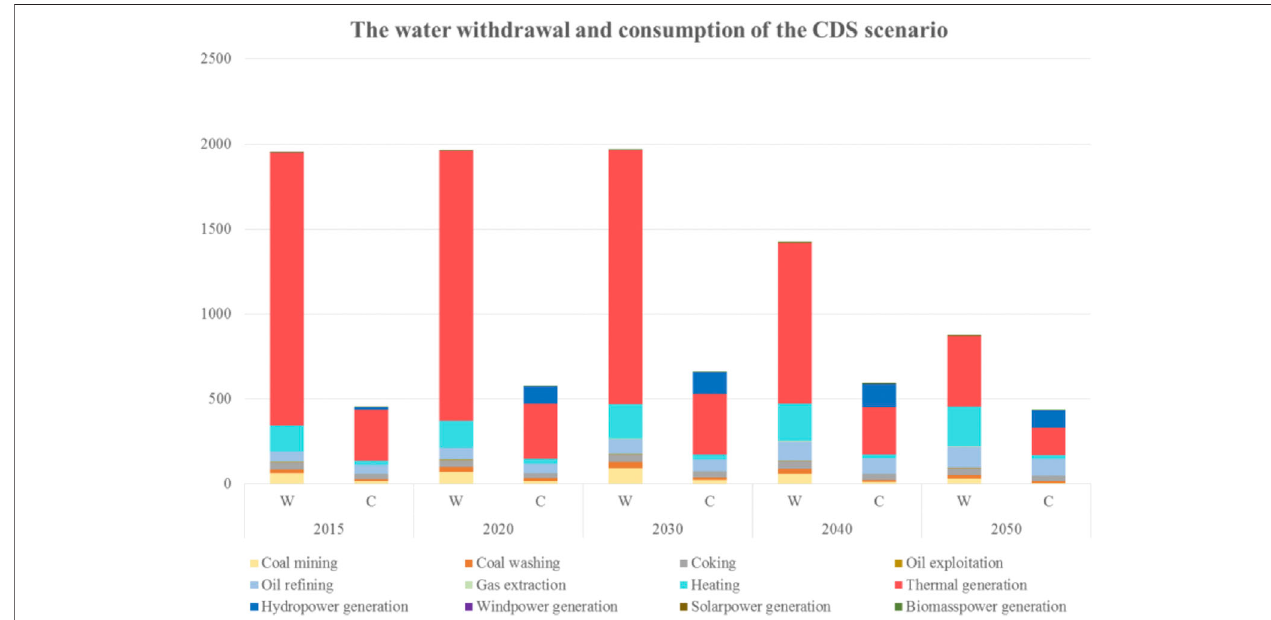
Frontiers in Energy Research |